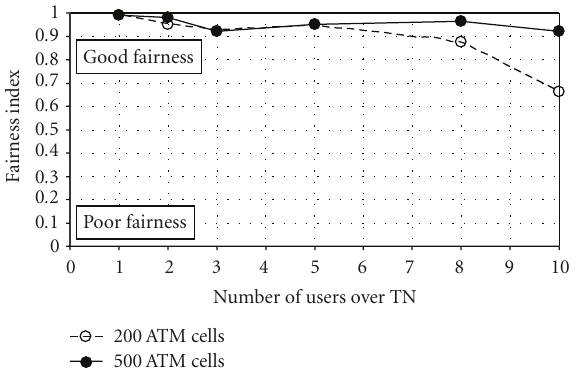
Figure 9: Jain’s fairness index in case of 2Mbps TN.